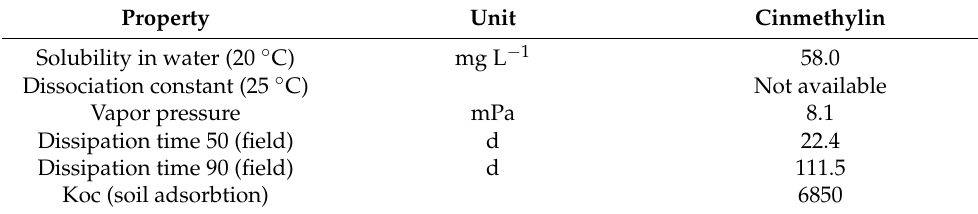
Table 1. Characterization of the properties of cinmethylin [23]. Property Unit Cinmethylin Solubility in water (20 ◦ C)